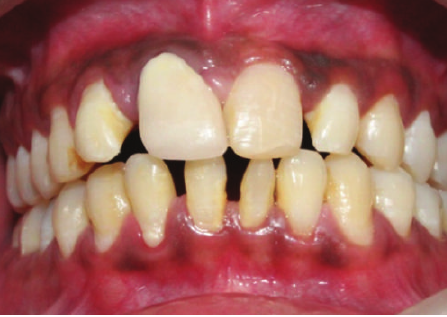
Figure 40: Temporisation.